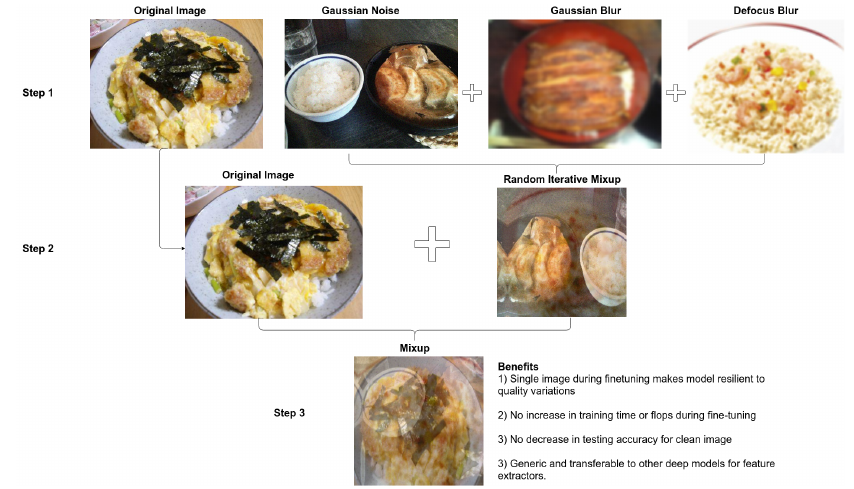
Figure 2. Proposed data augmentation for quality resilient feature